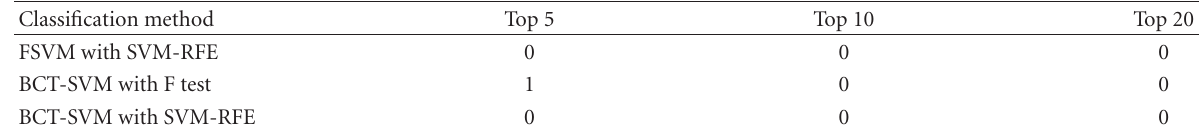
Table 3. Classifiers’ performance on hereditary breast cancer dataset by cross-validation (number of wrong classified samples in leave-one-out test).